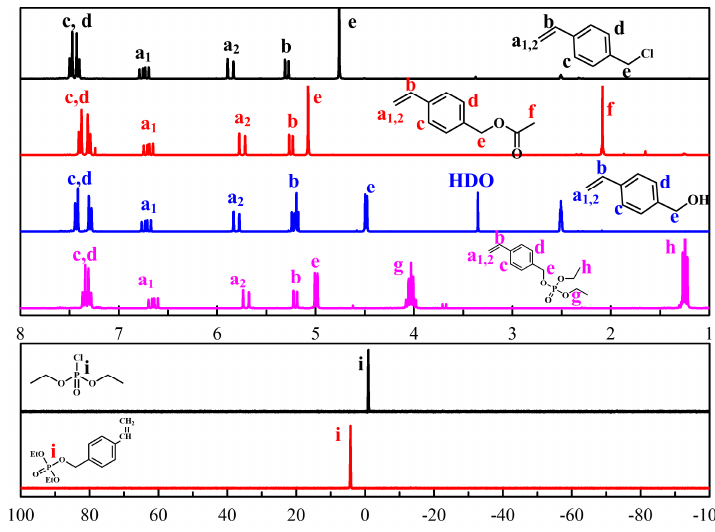
Figure 2. 1 H (4-vinylbenyl chloride, 4-vinylbenzyl acetate, 4-vinylbenzyl alcohol, diethyl 4-vinylphenyl phosphate) and 31P NMR spectra (diethyl chlorophosphate, diethyl 4-vinylphenyl phosphate).